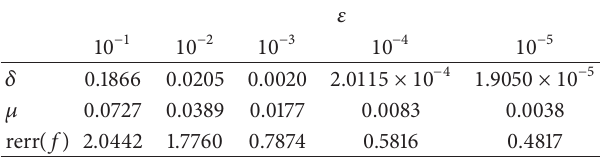
Table 1: 𝛿 , 𝜇 and the relative error rerr( 𝑓 ) with 𝑘 = 2 , 𝑝 = 1 and 𝜇 = (𝛿/𝐸) 1/3 for different 𝜀 .